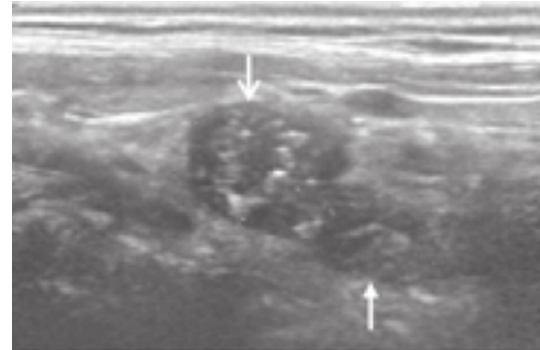
Figure 2 The nodule is larger and roundish in the head section (open arrow indicating) and narrows down (closed arrow indicating) into the mediastinum.